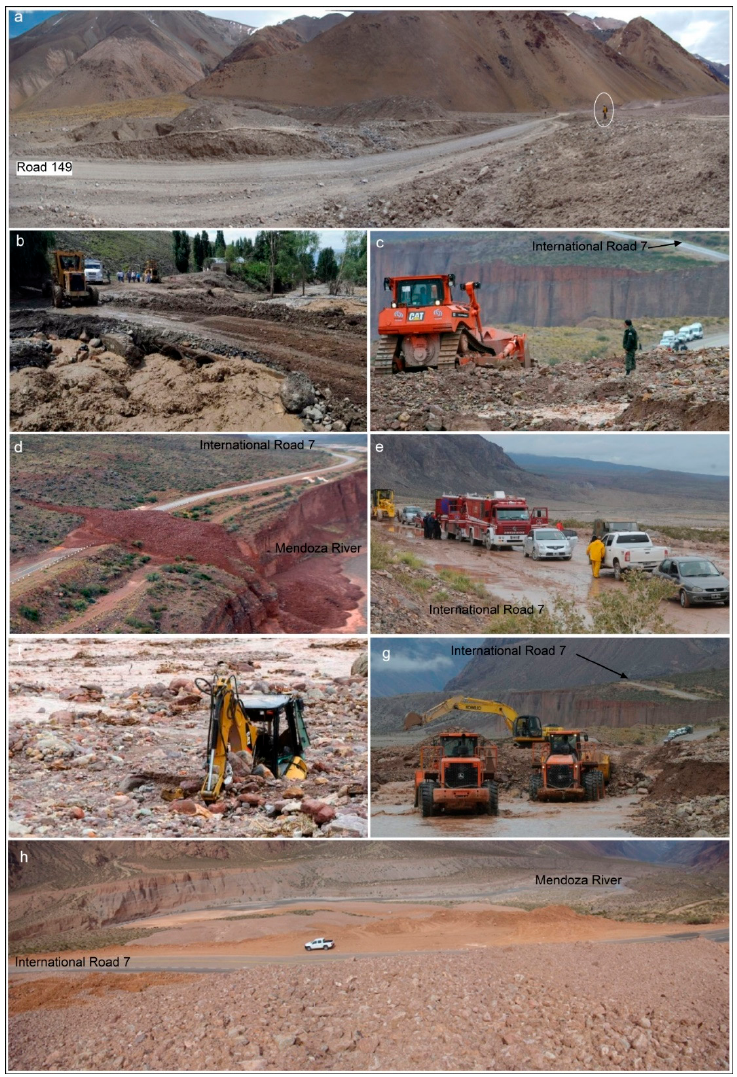
Figure 6. Events triggered by rainstorms during summer ( a ) event occurred on 8th February 2013 in the Agua Negra valley [71], in circle, a person as scale; ( b ) the bridge destroyed by the DF channeled in Las Mulas creek (Salto River, 33° S) on 7th February 2013 isolating the Valle del Sol locality [70]; ( c , d ) DFs in Picheuta area affecting the international road on 7th Feb 2013 [11]; ( e–g ) events recorded in Seca creek on 23th January, one roofed a bulldozer during the night [11]; and ( h ) event occurred in Picheuta region on 7th February 2015 with an estimated volume ~ 115.000 m 3 [11].